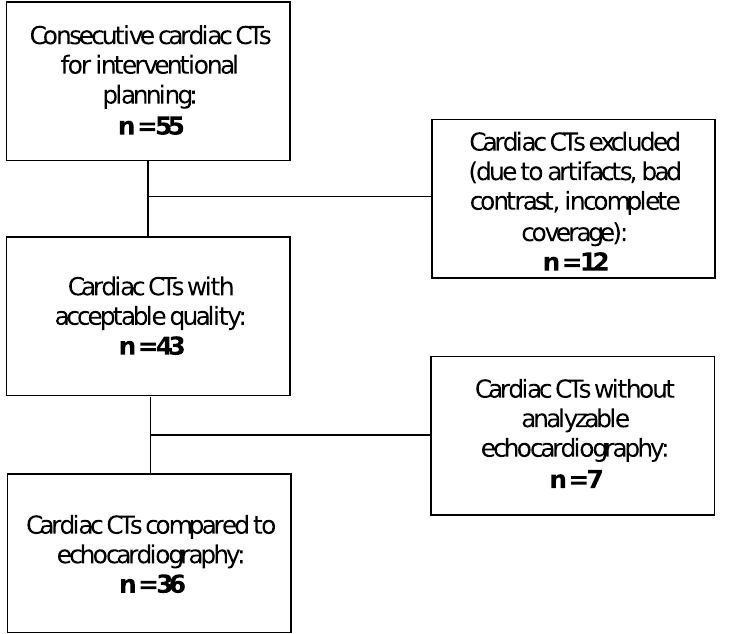
Figure 1. Flow chart of the patients in the study. 55 consecutive cardiac CTs, which were obtained for interventional planning of the cardiac valves were screened and 12 CTs were excluded due to either severe artifacts, bad contrast or incomplete coverage of the left ventricle. In the remaining 43 cardiac CTs myocardial strain was assessed. 7 of these 43 cardiac CTs had no analyzable echocardiography. In the remaining 36 examinations the myocardial strain measurements between echocardiography and cardiac CT were compared.